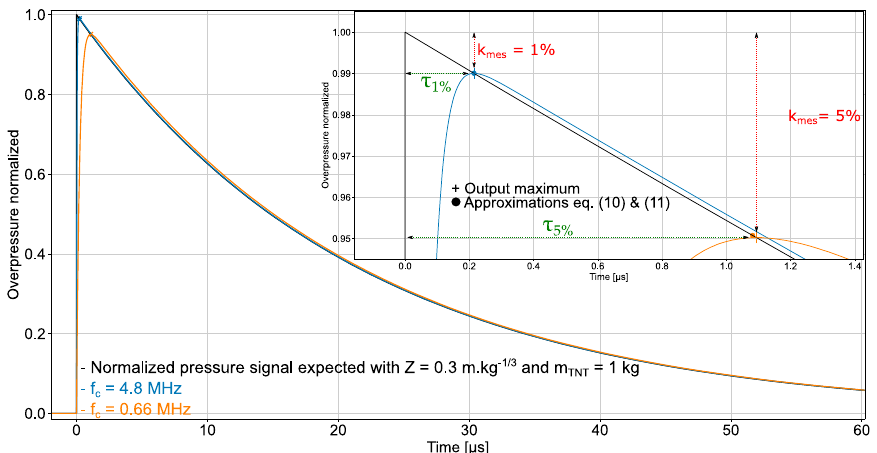
Figure 3. Friedlander waveform (derived from K&B data with Z = 0.3 m.kg − 1/3 and m TNT = 1 kg, surface burst and side-on pressure measurement) applied to the input of two first-order low-pass filters with different cut-off frequency f c (4.8 MHz and 660 kHz) and waveforms delivered at the filters’ output. The ordinate is the ratio ∆ P ( t ) / ∆ P MAX .